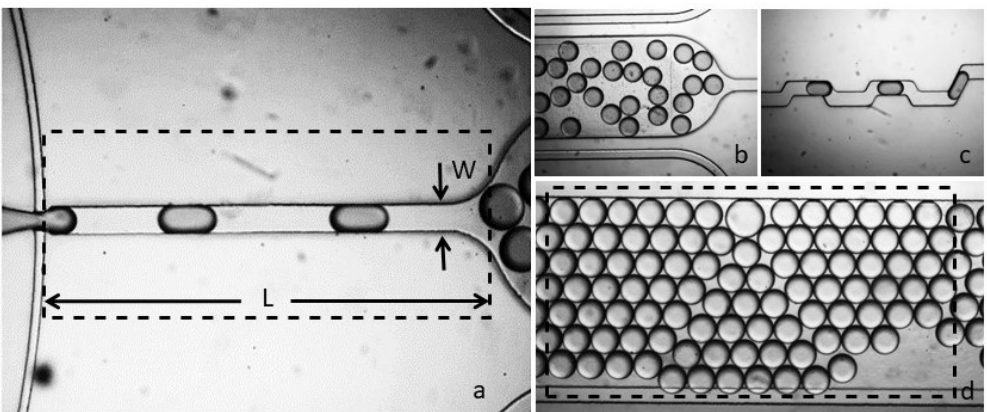
Figure 4. The fabricated flow-focusing assembly, ( a ) drive channel with width W and length L, ( b ) droplet generation at 500 uL/h and 100 uL/h for drive and dispersed phase, ( c ) output channel for droplet frequency monitoring, ( d ) micro-analysis and storage